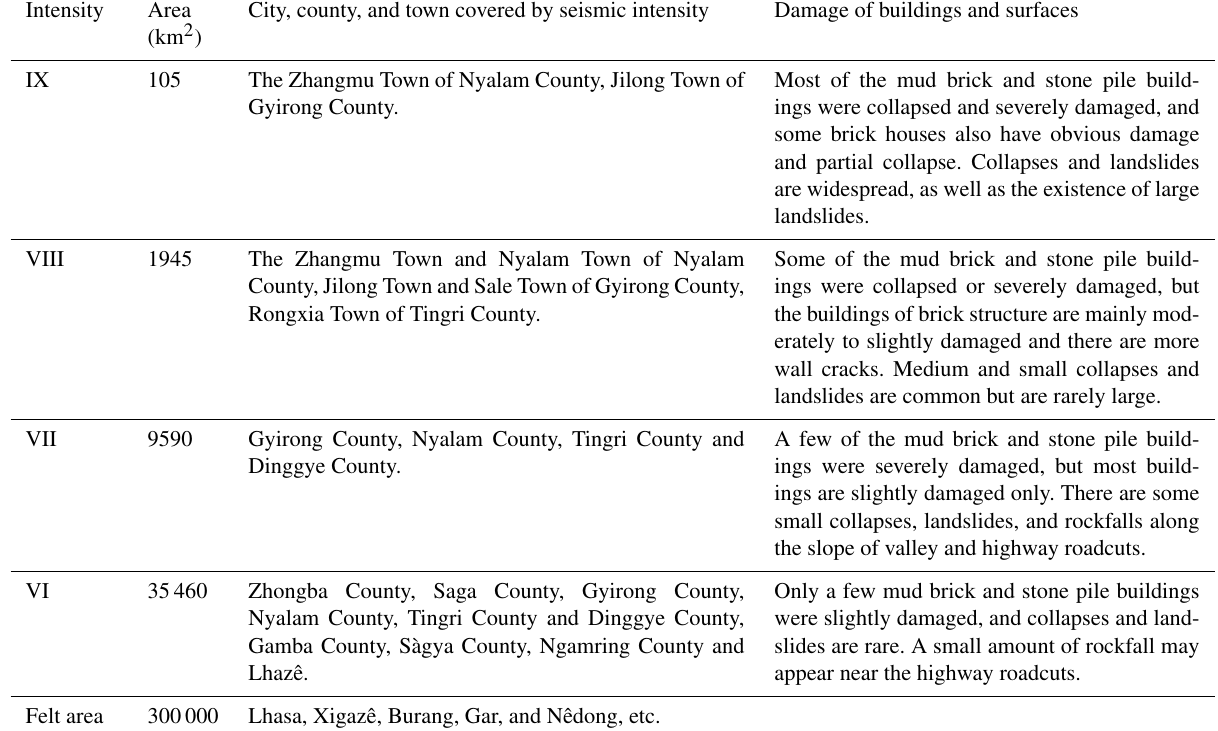
Table 2. Distribution of seismic intensity in the southern Tibet region from the Nepal earthquake. Intensity Area City, county, and town covered by seismic intensity Damage of buildings and surfaces (km 2 )